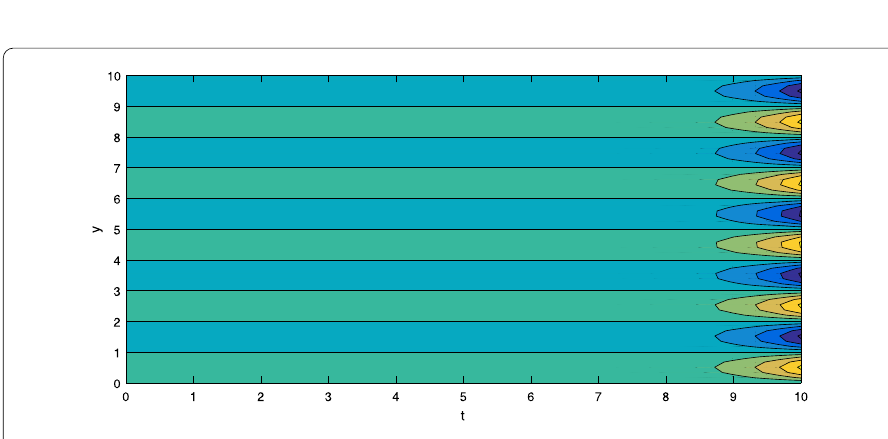
Figure 4 The contour plot of the solution curves given by (47) of fractional heat equation (1) for constant values of x = 0.5, z = 0.5 at different values of α = 0.4,0.6,0.8,1.0 in the ty -plane